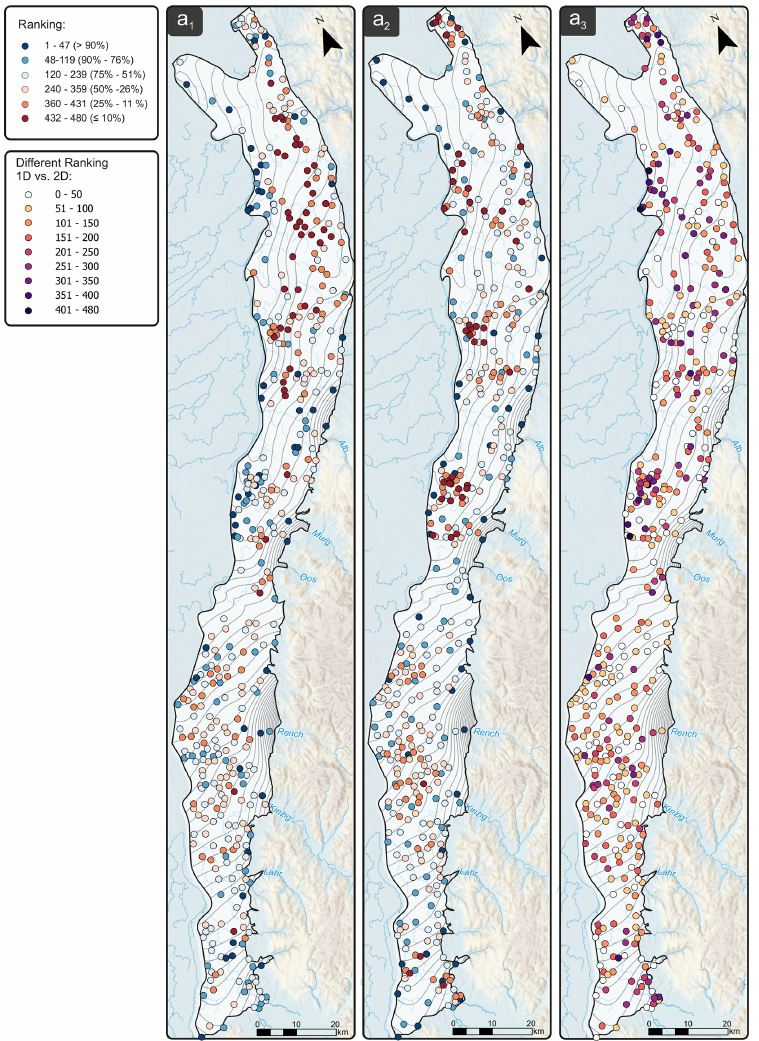
Figure A1. Comparison of QR-based ranking with 1D hydrograph data (left; panel a 1 ), with 2D interpolated GWL contour maps (middle; panel a 2 ) and differences of rankings between 1D and 2D (right; panel a 3